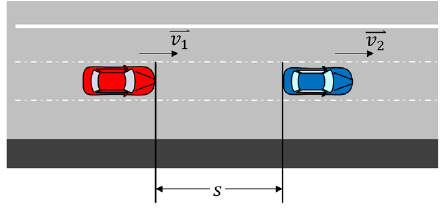
Figure 1. An illustration of TTC.